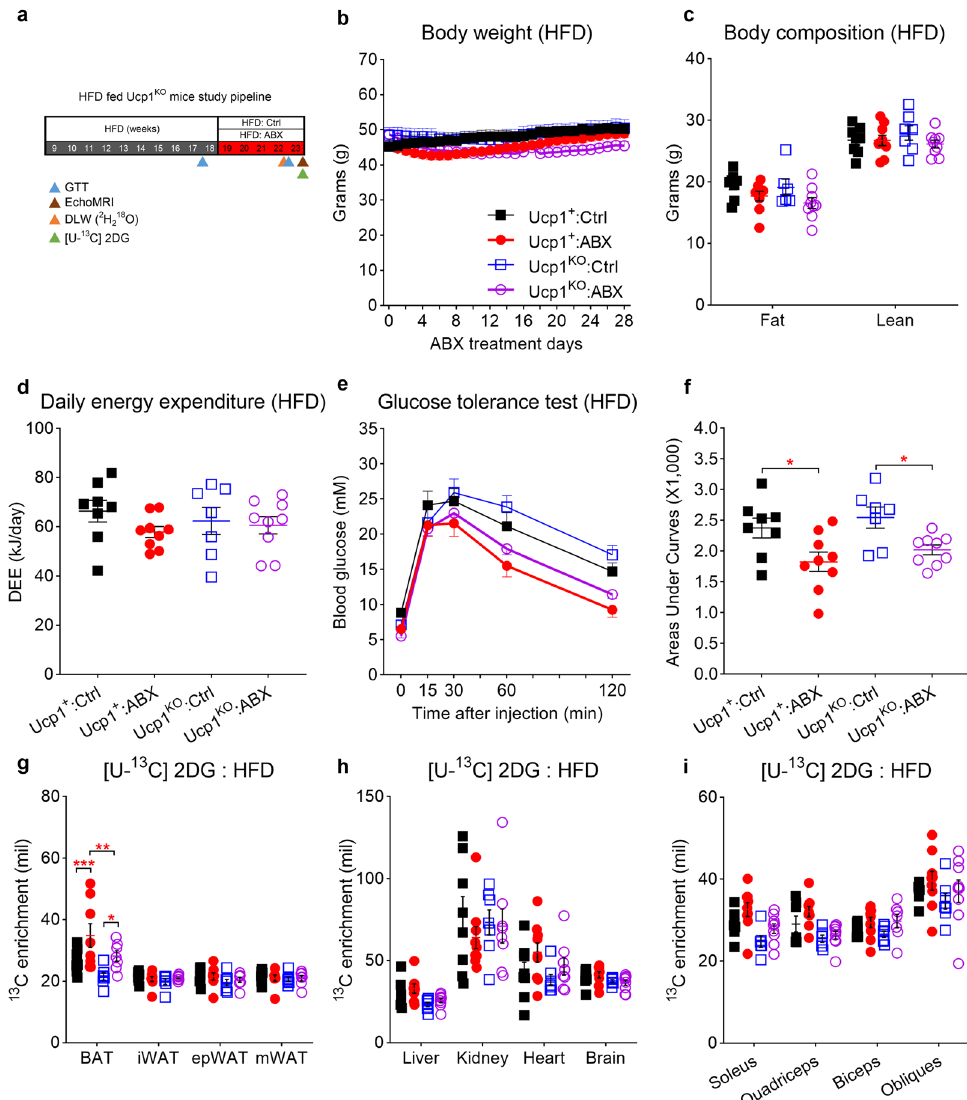
Fig. 3 UCP1 is dispensable for gut microbiota depletion-induced glucose improvement. a Experimental scheme. 10-weeks high-fat diet (HFD)-fed Ucp1- KO mice and its sibling controls subject to ABX treatment. Ucp1 + :Ctrl group (black square) and Ucp1 KO :Ctrl group (blue empty square) were Control groups, Ucp1 + :ABX group (red circle) and Ucp1 KO :ABX group (purple empty circle) received 5 weeks of ABX treatment (Ucp1 + : Ctrl, n = 9; Ucp1 + : ABX, n = 9; Ucp1 KO : Ctrl, n = 7; Ucp1 KO : ABX, n = 9). The results shown are representative of two independent experiments. b – d Body mass curves ( b ), fi nal body composition ( c ), and daily energy expenditure ( d ) of HFD-fed Ucp1-KO mice and its sibling at Control or ABX condition (Ucp1 + : Ctrl, n = 8; Ucp1 + : ABX, n = 9; Ucp1 KO : Ctrl, n = 7; Ucp1 KO : ABX, n = 9). e , f Intraperitoneal glucose tolerance test (ipGTT) and total glucose area under the curves (AUC) at the fourth week of ABX treatment (Ucp1 + : Ctrl, n = 9; Ucp1 + : ABX, n = 9; Ucp1 KO : Ctrl, n = 7; Ucp1 KO : ABX, n = 9) (Ucp1 + , P = 0.011 ; Ucp1 KO , P = 0.017). g – i 2DG enrichment in fat depots ( g ), skeletal muscle ( i ), and other tissues ( h ) after intraperitoneal injection of [U- 13 C] labelled 2DG to mice at the 5th week of ABX (Ucp1 + : Ctrl, n = 8; Ucp1 + : ABX, n = 9; Ucp1 KO : Ctrl, n = 7; Ucp1 KO : ABX, n = 7) (BAT, Ucp1 + : Ctrl vs Ucp1 + : ABX, P < 0.001; Ucp1 + : ABX vs Ucp1 KO : ABX, P = 0.008 ; Ucp1 KO : Ctrl vs Ucp1 KO : ABX, P = 0.012). All statistical analyses were performed by two-way ANOVA with Bonferroni ’ s multiple comparisons. All results are given as mean ± SEM. Differences with P < 0.05 were considered to be signi fi cant. P < 0.05 (*), P < 0.01 (**), and P < 0.001 (***). See also Supplementary Fig. (Fig. 3a). Five weeks of ABX treatment at 22 °C did not affect body weight (two-way ANOVA, F 3, 29 = 1.62, P = 0.206) or food intake (two-way ANOVA, F 3, 29 = 2.161, P = 0.114) in HFD-fed